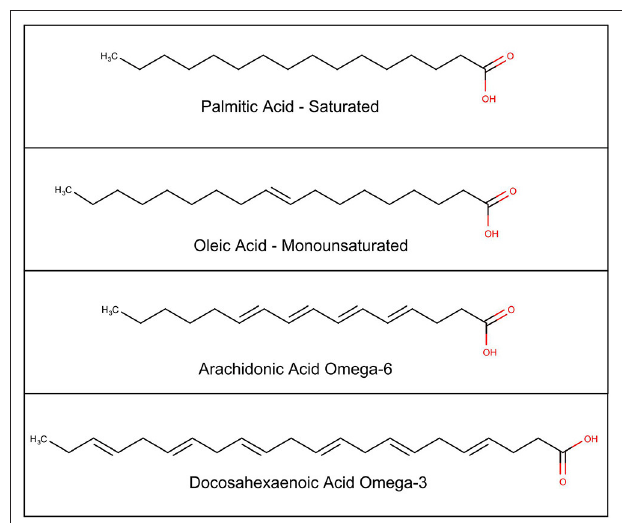
FIGURE 2 | Chemical structure of selected fatty